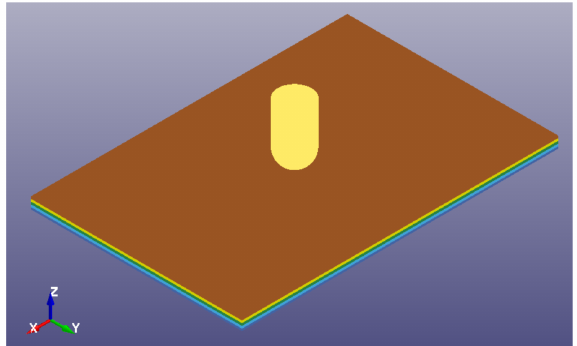
Figure 10. FE model of the LVI setup in LS-DYNA ®